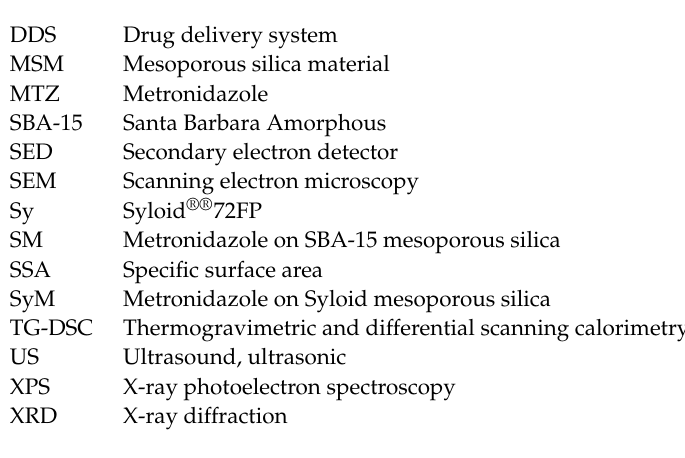
surface; (b): Scanning electron micrographs of the Syloid and SBA-15 carriers and metronidazole immobilized on their surface; (c) Scanning electron micrographs of the Syloid and SBA-15 carriers and metronidazole immobilized on their surface; (d) Scanning electron micrographs of the Syloid and SBA-15 carriers and metronidazole immobilized on their surface; (e) Scanning electron micrographs of the Syloid and SBA-15 carriers and metronidazole immobilized on their surface; (f) Scanning electron micrographs of the Syloid and SBA-15 carriers and metronidazole immobilized on their surface; Figure S4: (a) Quantitative thermogravimetry of Syloid samples; (b) Quantitative thermogravimetry of Syloid samples; (c) Quantitative thermogravimetry of SBA-15 samples; (d) Quantitative thermo- gravimetry of SBA-15 samples; (e) Quantitative thermogravimetry of SBA-15 samples; (f) Quantitative thermogravimetry of SBA-15 samples; Figure S5: (a) Quantitative DSC of Syloid samples; (b) Quan- titative DSC of Syloid samples; (c) Quantitative DSC of SBA-15 samples; (d) Quantitative DSC of SBA-15 samples; (e) Quantitative DSC of SBA-15 samples; (f) Quantitative DSC of SBA-15 samples; Table S1: Differences of metronidazole percentage dissolution (%) as function of time; Table S2: Dissolution speed (% min − 1 ) of metronidazole and its release speed from the composites as function of